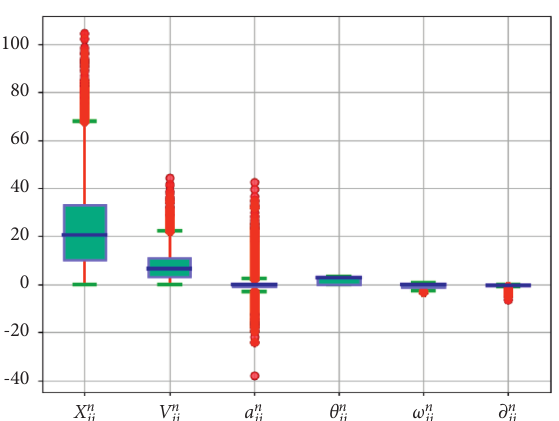
Figure 9: Box diagram of vehicle behavior in the vehicle exit